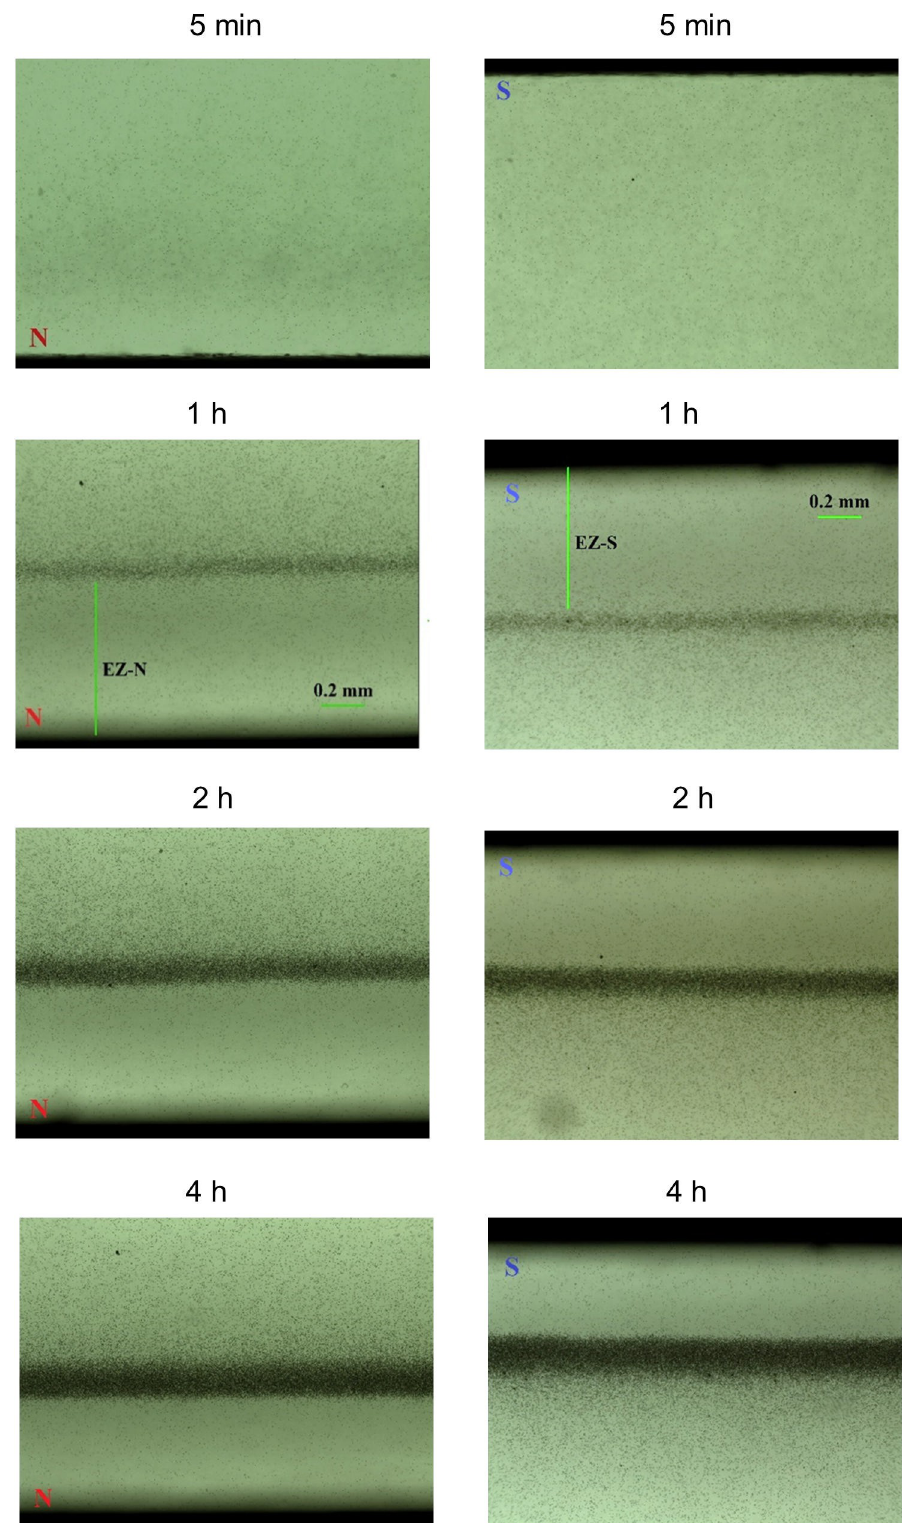
Fig 3. Representative time-dependent changes in microsphere concentration near North (N) and South (S) poles.